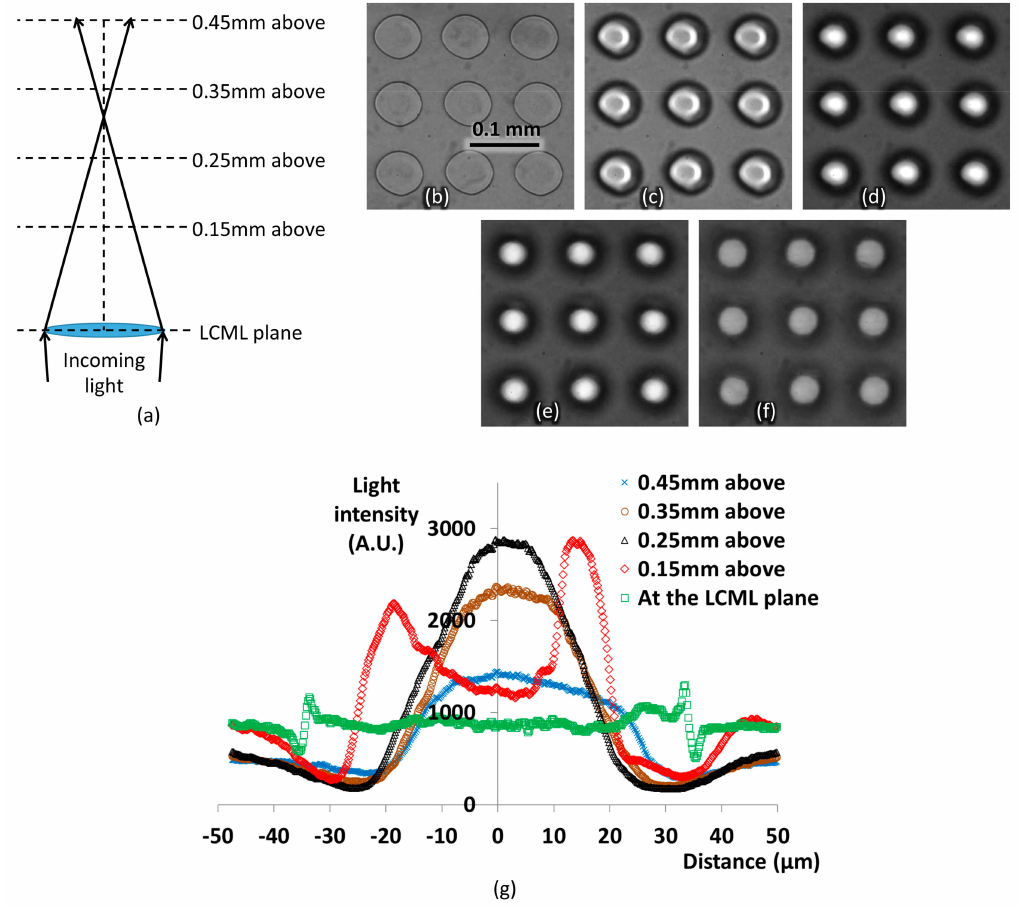
Figure 5. ( a ) A sketch of the microscope measurement setup. Images when the microscope is focused at ( b ) the LCML plane, ( c ) 150 µ m above the LCML plane, ( d ) 250 µ m above the LCML plane, ( e ) 350 µ m above the LCML plane, and ( f ) 450 µ m above the LCML plane. ( g ) Line profiles of light intensity across the centre of an LCML in the horizontal